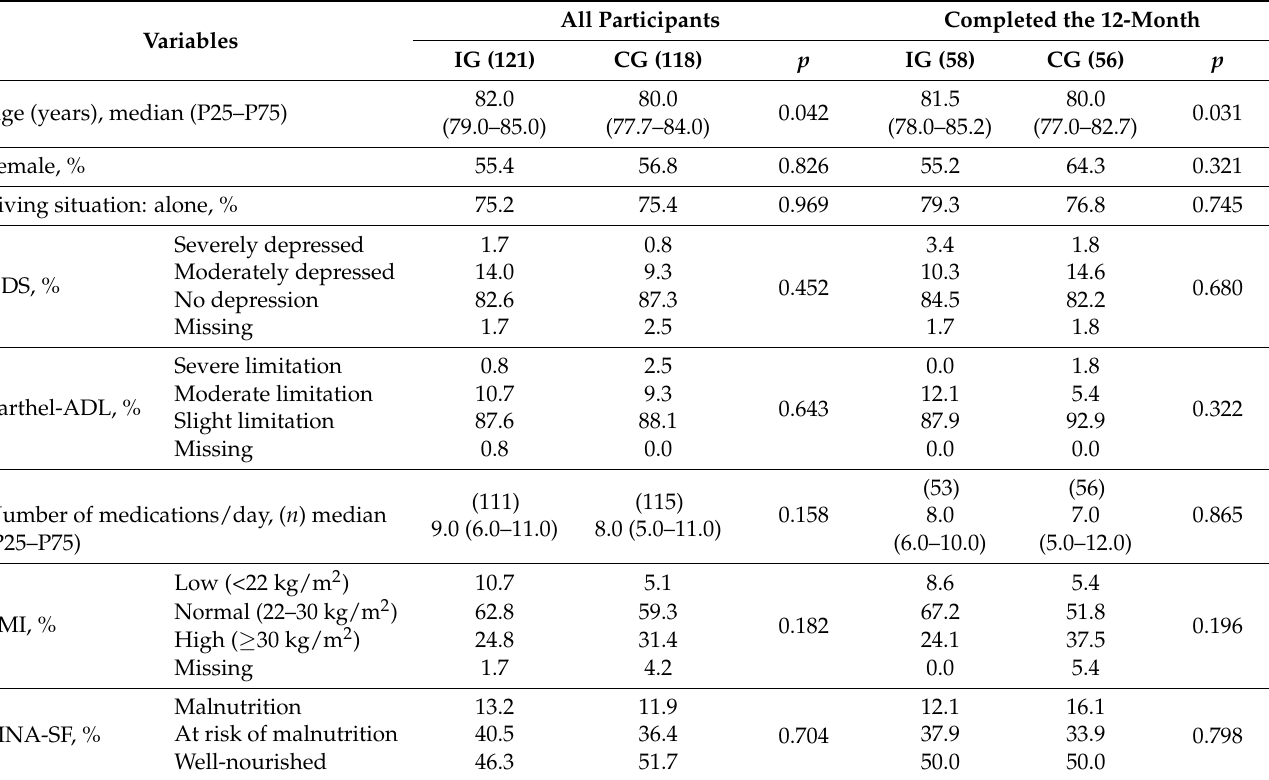
Table 2. Baseline characteristics and nutritional status of all participants and the subgroup of those who completed the 12-month follow-up.